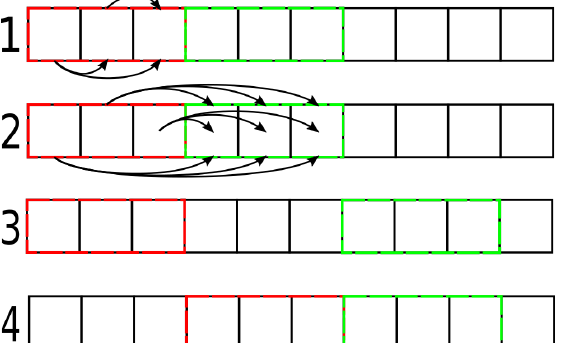
Figure 6. Data processing using two buffers. First, we process images in the first (red) buffer ( 1 ), then all pairs of images in both buffers ( 2 ). We iteratively fill the second (green) buffer with remaining images ( 3 , arrows skipped for brevity). When all images pairs for the first buffer are processed, we load new images into the first buffer ( 4